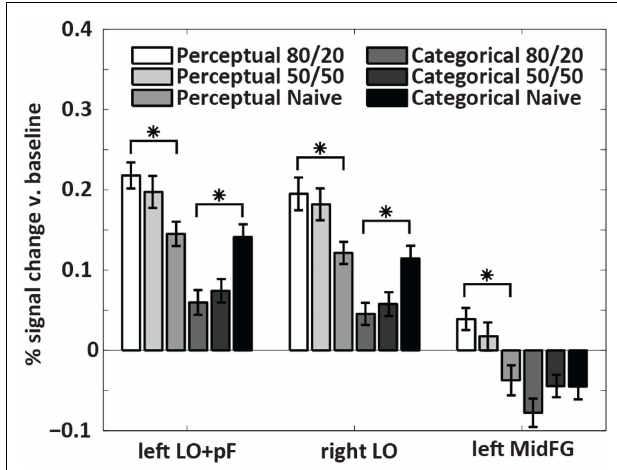
FIGURE 5 |Within-ROI results. The bar charts show mean brain activity across all decision trials, relative to blanks, in each condition. Stars indicate differences of p < 0.05 as calculated with a two-tailed t -test. In the naïve subjects, decisions under perceptual uncertainty evoked the same level of within-ROI activity as decisions under categorical uncertainty. Adding the prior knowledge cue to decisions under perceptual uncertainty visual targets increased activation in visual association and prefrontal cortices relative to no prior knowledge cue. Adding the prior knowledge cue to decisions under categorical uncertainty decreased activation in visual association cortex relative to no prior knowledge cue. In left MidFG, only decisions made under perceptual uncertainty with the 80/20 prior knowledge cue resulted in positive brain activations; the mean activation with the 50/50 cue was not significantly above zero.